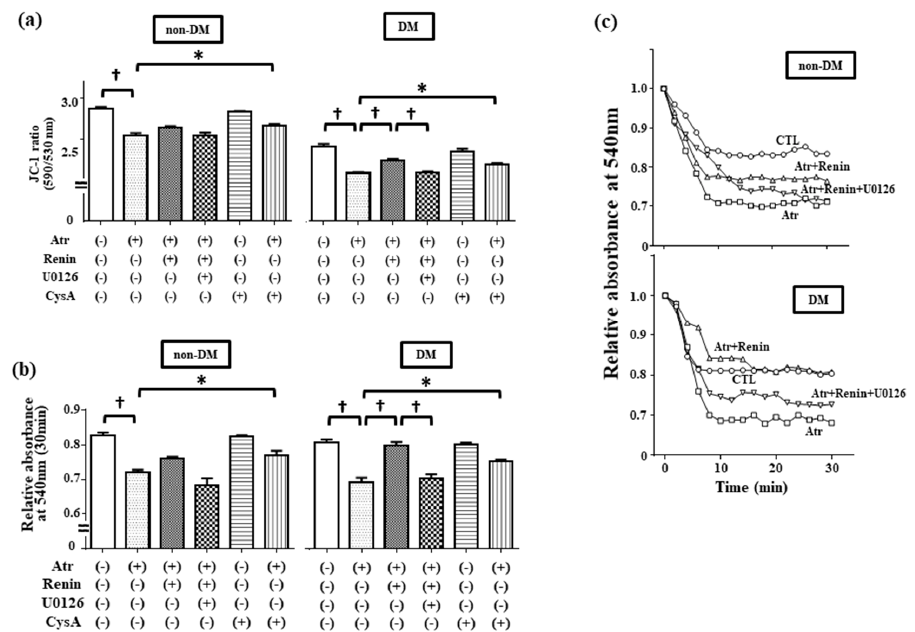
Figure 3. Rat recombinant renin (r-renin) inhibited atractyloside (Atr)-induced mitochondrial